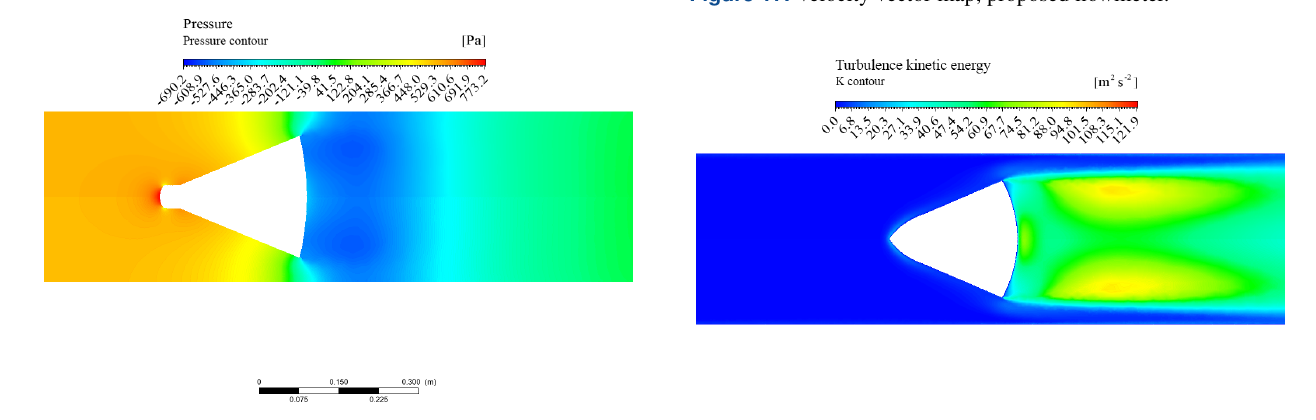
Figure 16. Relative static pressure contour plot.